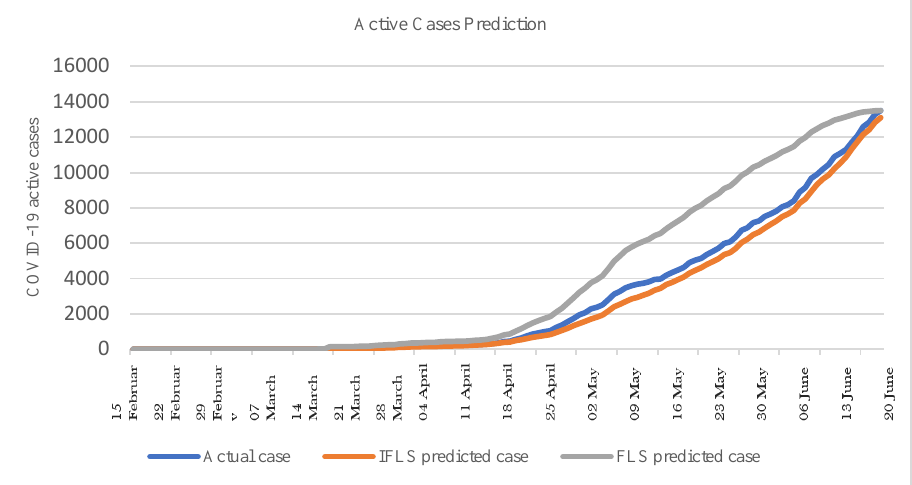
Fig. 7. Actual and predicted active cases of